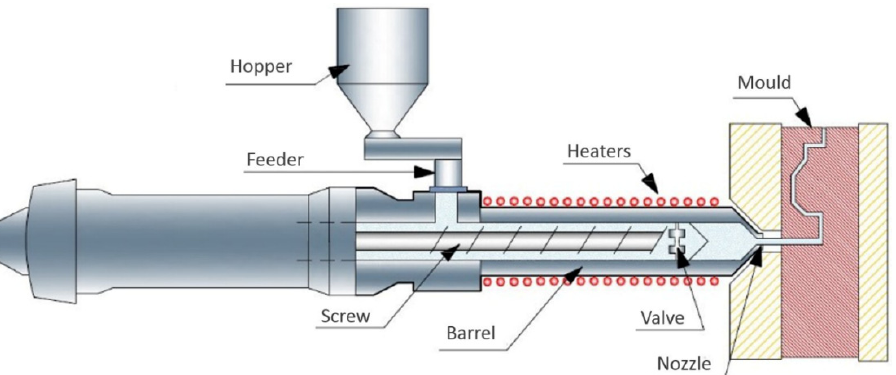
Figure 5. Schematic showing the thixomoulding process according to reference [32,33]. Reprinted under the Creative Commons Attribution License (CC-BY)